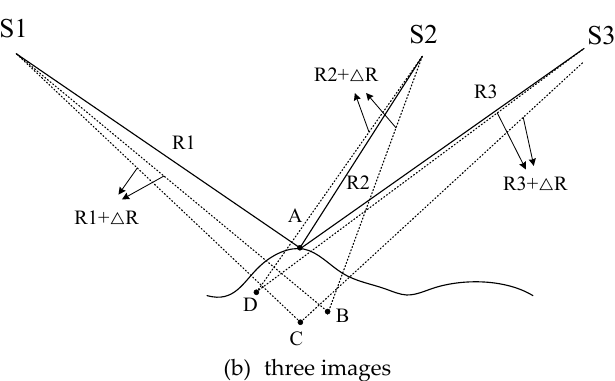
Figure 1. Schematic diagram of synthetic aperture radar (SAR) image geometric self-calibration. Accordingly, in Figure 1b, we add a third image, and the slant range between S3 and A is given by R3. However, due to the aforementioned errors, slant range R3 becomes R3 + △ R. New spatial intersection points then exist between S3 and S1 at Point C, and between S3 and S2 at Point D. If the change in slant range is caused by a ground point error, then spatial intersection Points B, C, and D should all be the same. If, however, the change in slant range is caused by a geolocation parameter error, then the spatial intersection Points B, C, and D are likely to be different. This difference is called the spatial intersection residual. A minimum spatial intersection residual can thus be used as a constraint condition for solving the self-calibration equation.